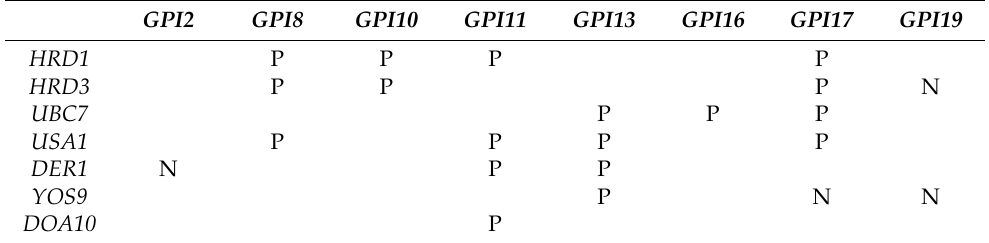
Table 1. Positive and negative genetic interactions between genes encoding ERAD components and GPI biosynthetic factors. N: negative genetic interactions; P: positive genetic